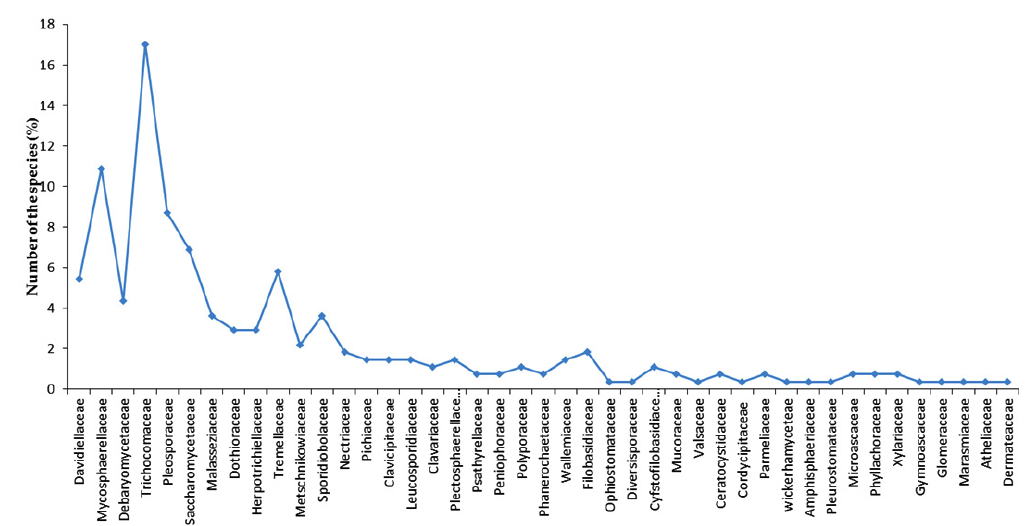
Fig. 4. The abundance of fungal families in all the polyherbal